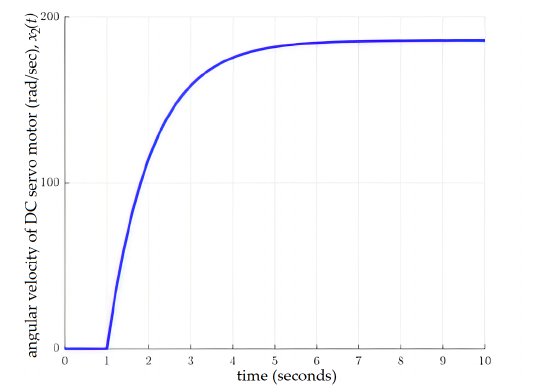
Figure 6. Open-loop step response for velocity of the DC servo motor.